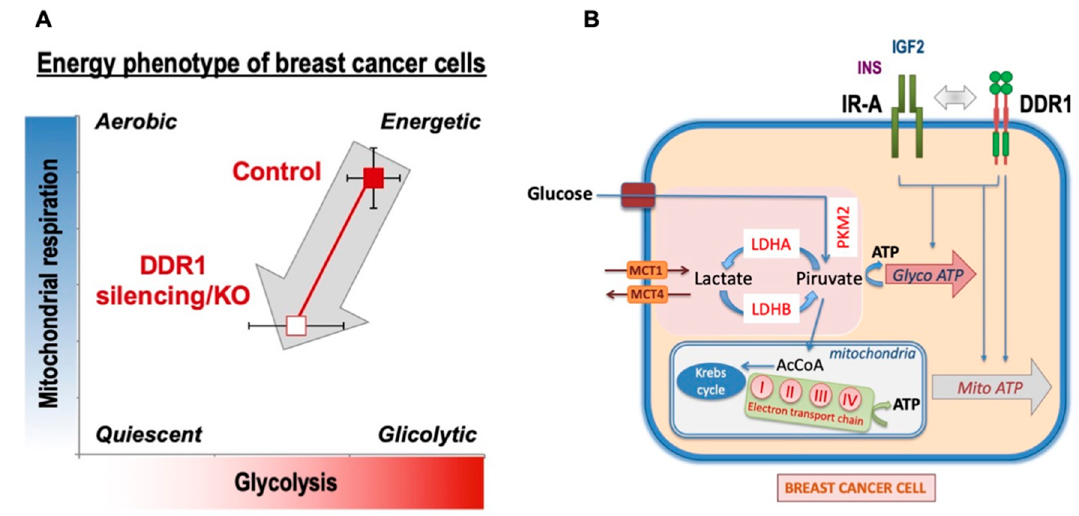
Figure 7. Schematic representation of the impact of DDR1 silencing/knocking out on MCF7 human breast cancer cells bioenergetics. ( A ) DDR1 silencing of MCF7 cells was accompanied by a reduction of ATP production (both glycoATP and mitoATP) also in the presence of IGF2, which is known to stimulate cell metabolism. A similar ATP reduction was observed in MCF7 DDR1-ve cells compared to the control cells. ( B ) Several key molecules involved in the regulation of both glycolysis and OxPhos were negatively affected by DDR1 silencing or knocking out. Together, the data support the notion that DDR1 targeting may negatively affect breast cancer cell bioenergetics at least partially by downregulating